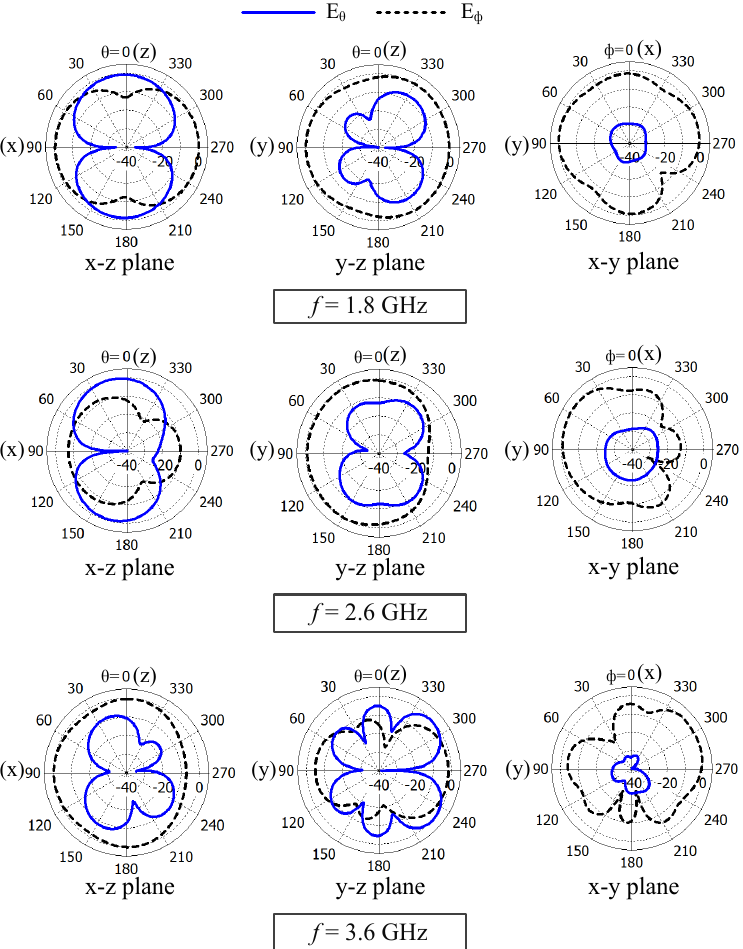
Figure 11. Normalized radiation patterns of the dual-band antenna (Ant#2) at 1.8, 2.6, and 3.6